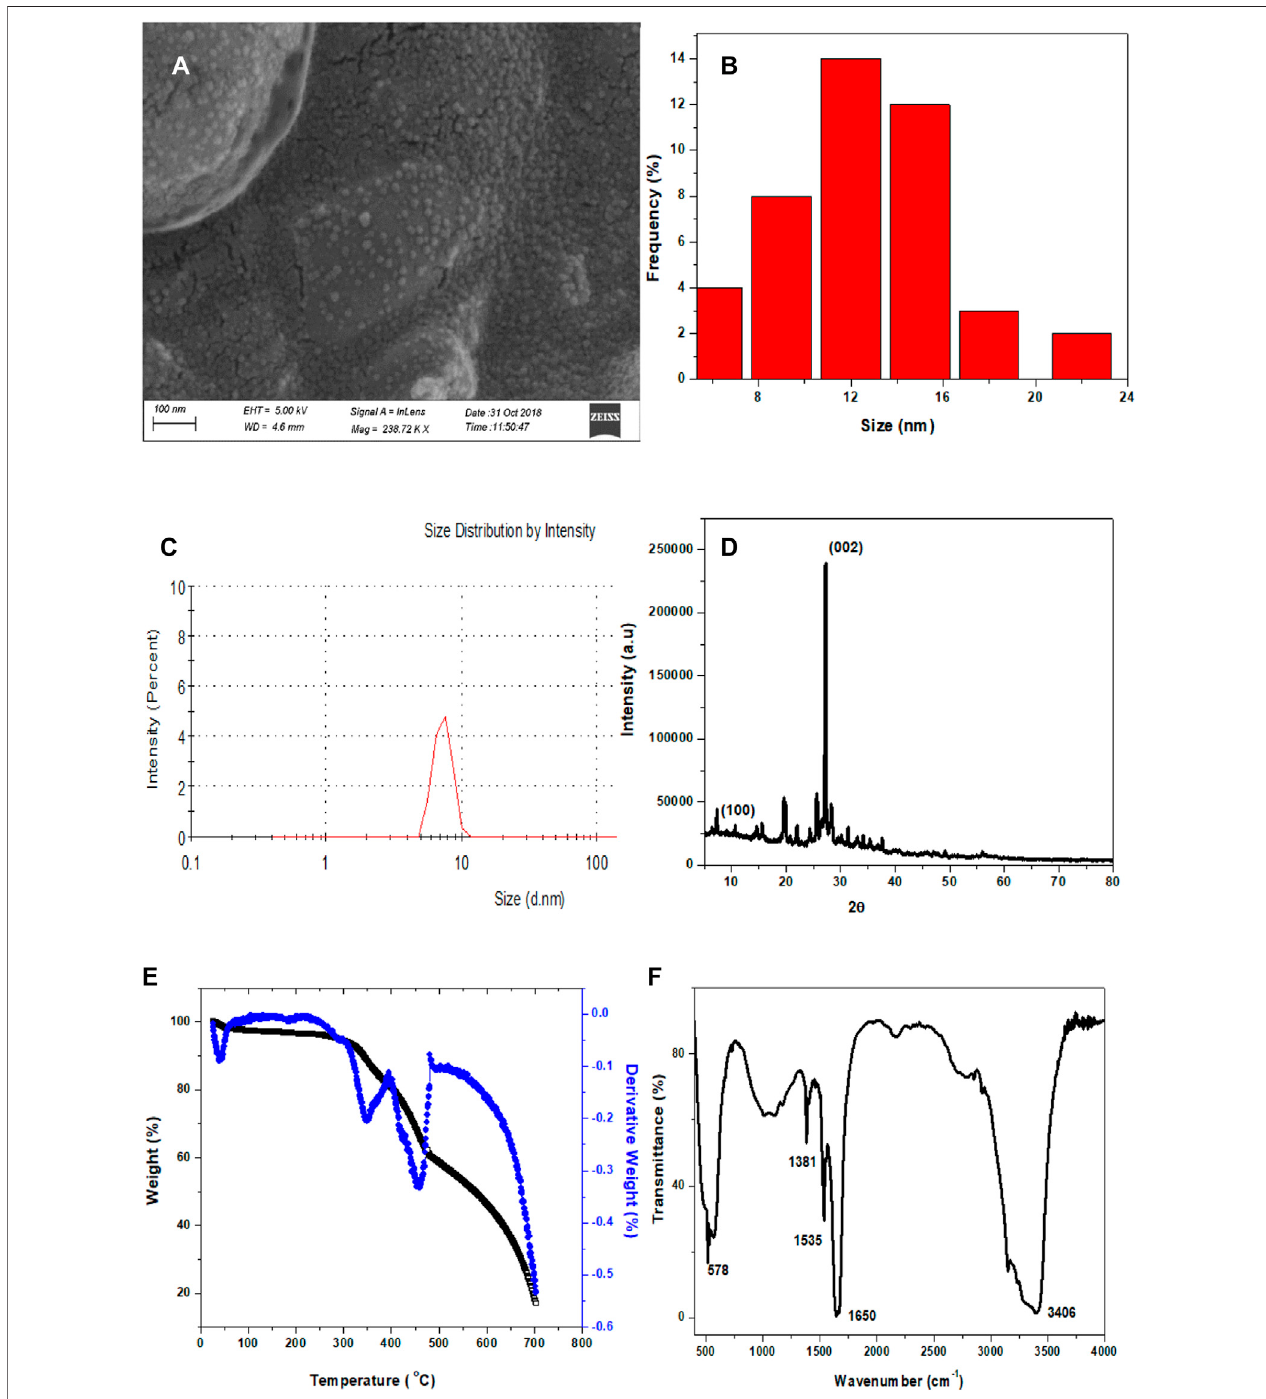
FIGURE 1 | (A) FESEM image of Cl-CNDs. (B) Particle size distribution from the FESEM image, calculated by using ImageJ software. (C) DLS of Cl-CNDs. (D) PXRD pattren of Cl-CNDs. (E) TGA (black line) and DTG (blue line) of Cl-CNDs. (F) FT-IR spectrum of Cl-CNDs.